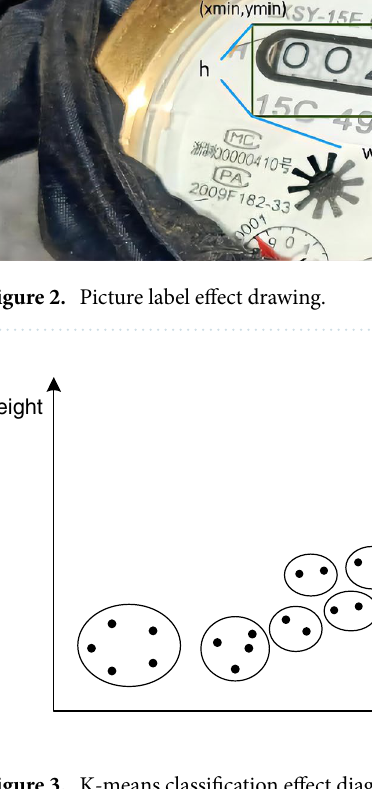
Figure 3. K-means classification effect diagram.